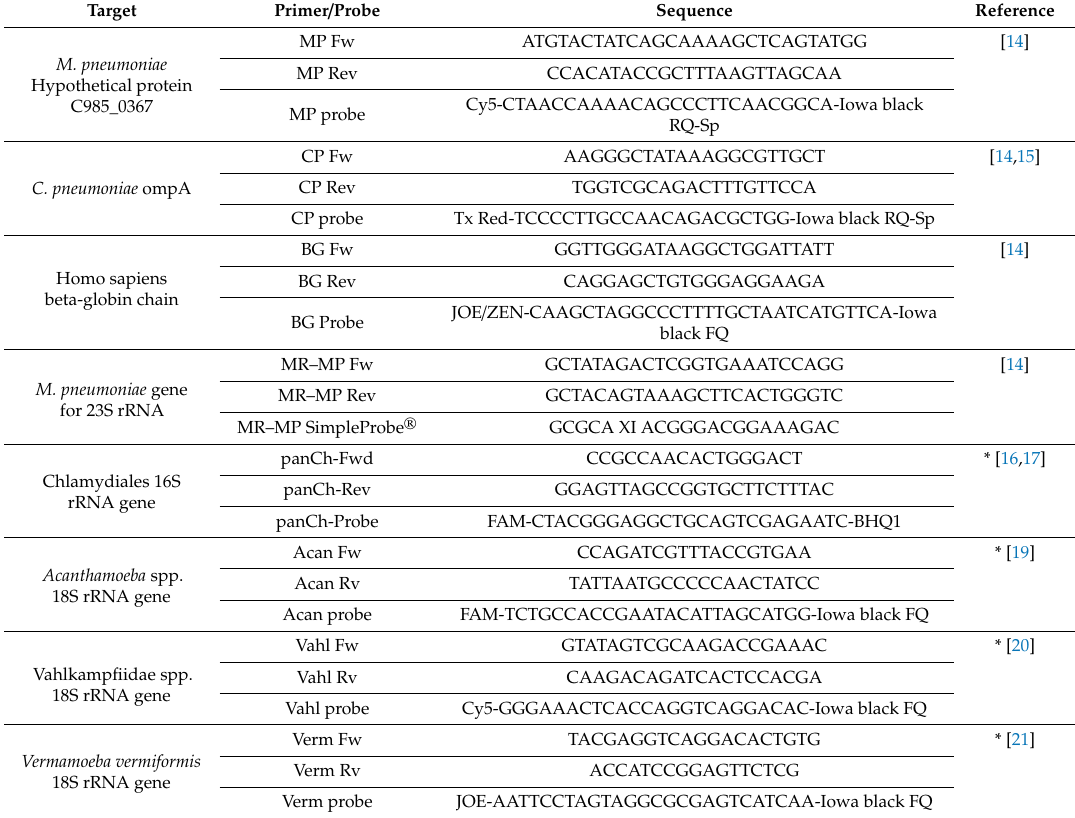
Table 1. Primers and probes used in this